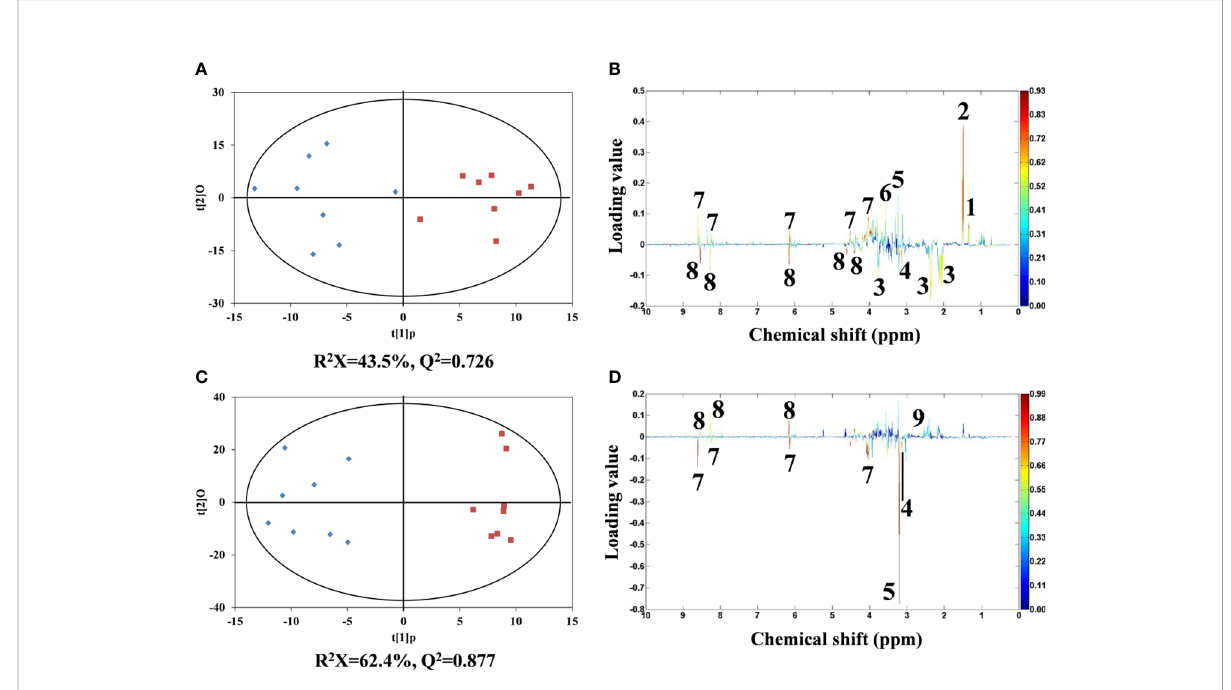
FIGURE 4 OPLS-DA scores derived from 1 H NMR spectra of fl ounder liver extracts from control ( ♦ ) and Cd treatments ( ▪ ). (A) 5 and (C) 50 µg/L of Cd treatments and corresponding coef fi cient plots (B) and (D) . The color map expresses the signi fi cance of metabolite variations between two classes (control and Cd treatments). Peaks in the positive and negative direction indicate metabolites that are more abundant in the Cd treatments and control group, respectively. Keys: (1) lactate, (2) alanine, (3) glutamate, (4) malonate, (5) phosphocholine, (6) glycine, (7) AMP, (8) ATP and (9)